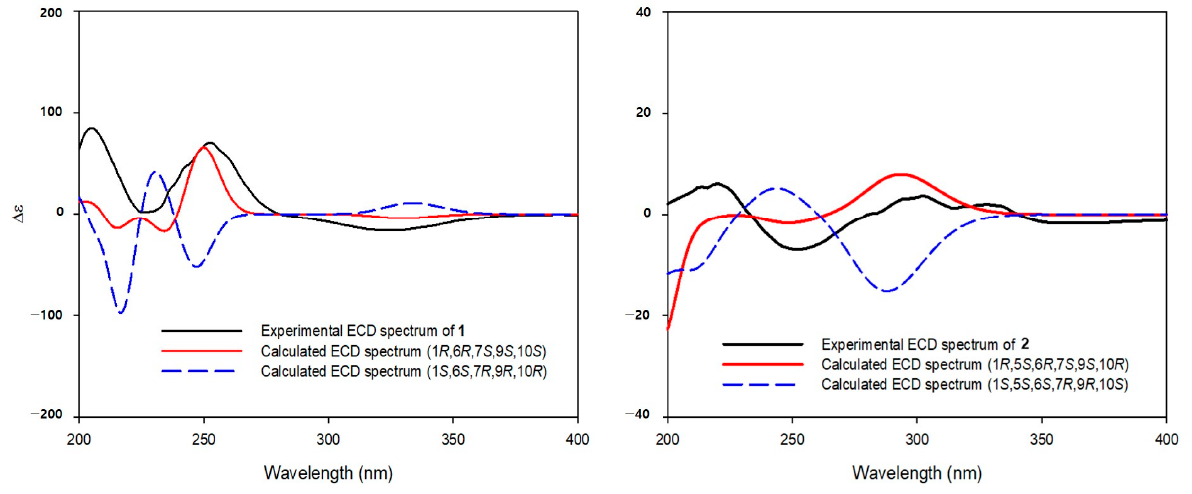
Figure 4. ECD spectra of compounds 1 and 2 .